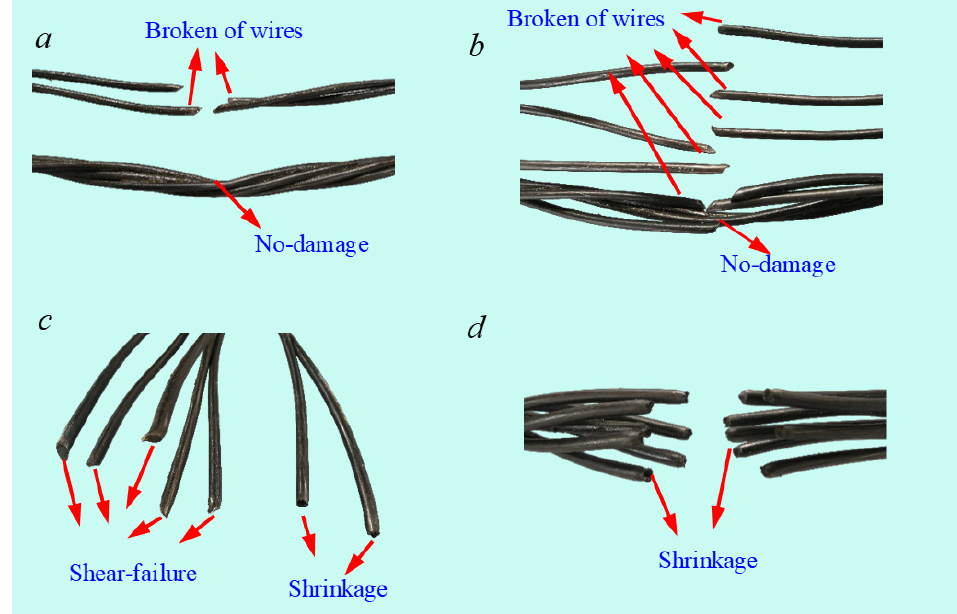
Figure 13. Details of failure patterns: ( a , b ) some wires broken; ( c ) all wires broken; ( d ) shrinkage of wires under uniaxial tension.